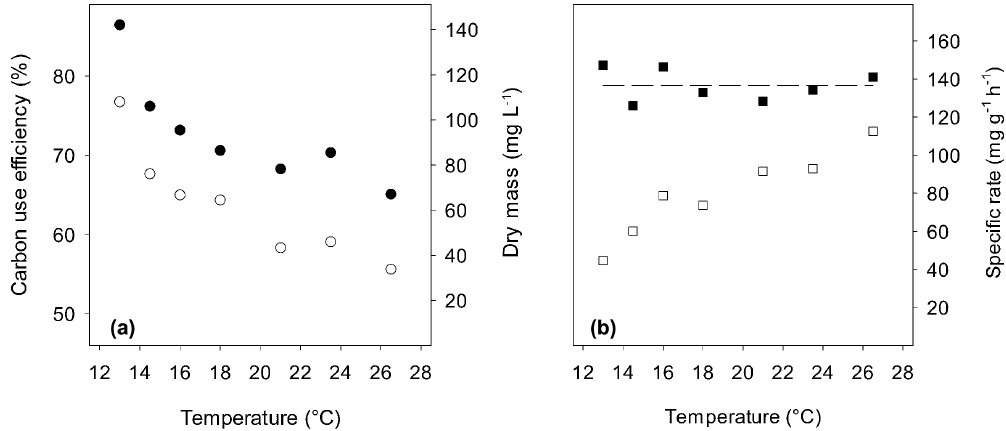
Fig. 3. Steady-state process variables of P. fluorescens growing in chemostats at specified temperatures. Microbial carbon use efficiency (○; A), dry microbial biomass (●; A); specific growth rate (■; B), and specific respiration rate (□; B), expressed in mg C per g of microbial biomass-C and hour . The dashed line denotes the average of the seven specific growth rates (137 mg g -1 h -1 ).